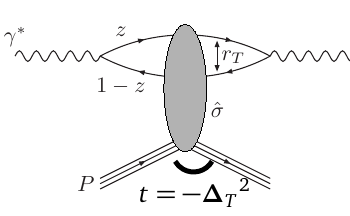
Figure 1: The dipole picture